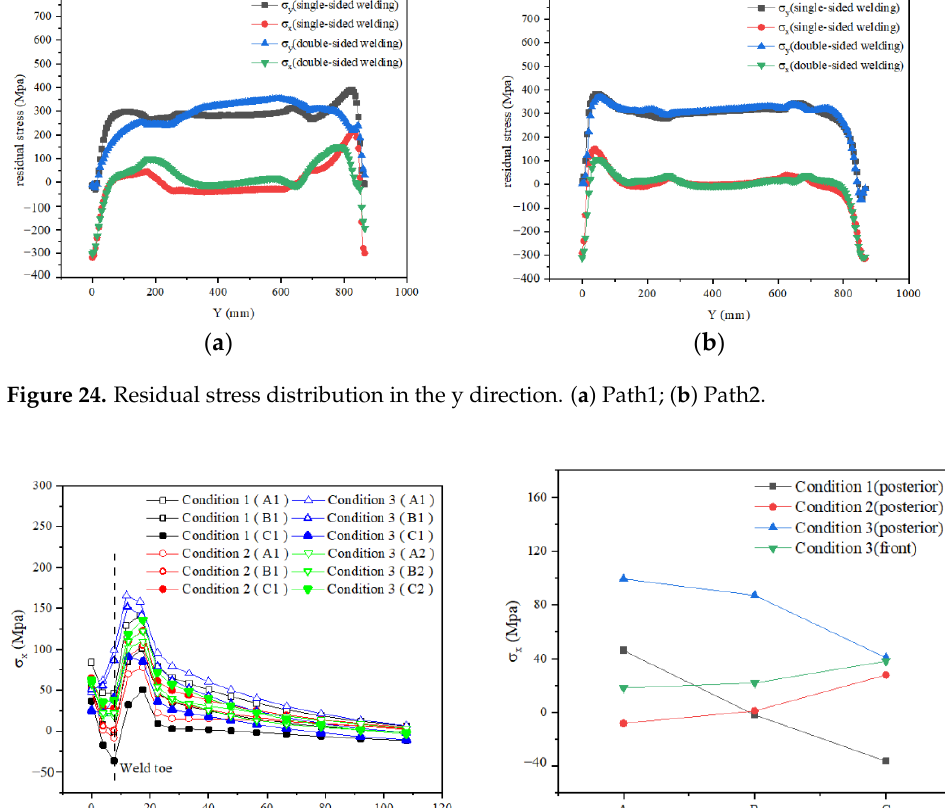
Figure 25. Residual stress distribution of σ x in different welding conditions. ( a ) Along the path di- rection; ( b ) Position of weld toe.